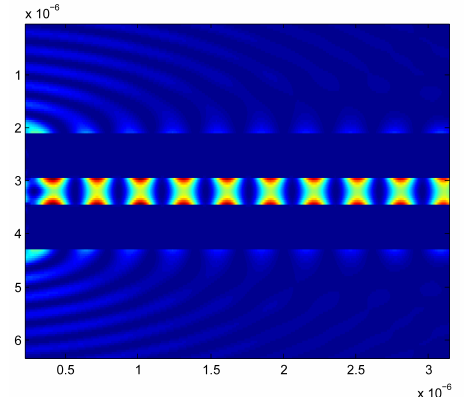
Figure 9: Snapshot of the instantaneous magnitude of the electric field strength in and around the plasmonic waveg- uide after 100 GMRES iterations.